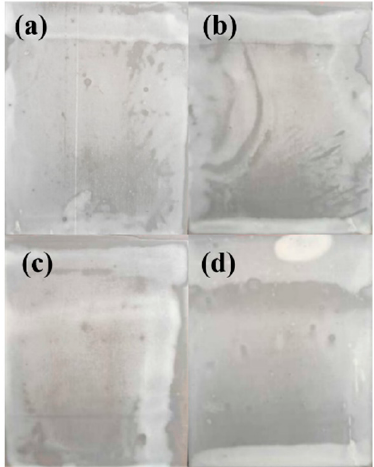
Figure 11. The morphology of coatings: ( a ) Ad-1, ( b ) Ad-2, ( c ) Ad-3 and ( d ) Ad-8. Ad-1, Ad-2, Ad-3 and Ad-8 are used for oriented silicon-steel sheets. In Figure 10, all